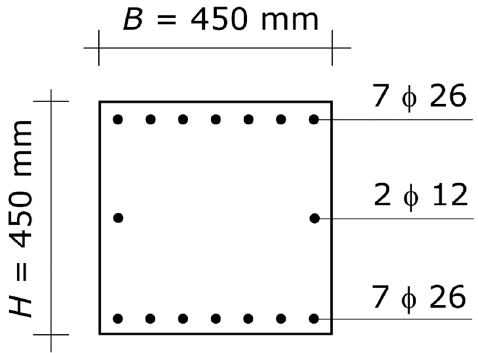
Figure 5. Optimal column of the first application example. Cross-section of the column. The diagram shows the concrete section and the longitudinal steel reinforcement, while it does not show the hoops (which shall be designed at a following stage of the structural design). The symbol φ denotes the diameter of the bars (it is the symbol used in Italy).